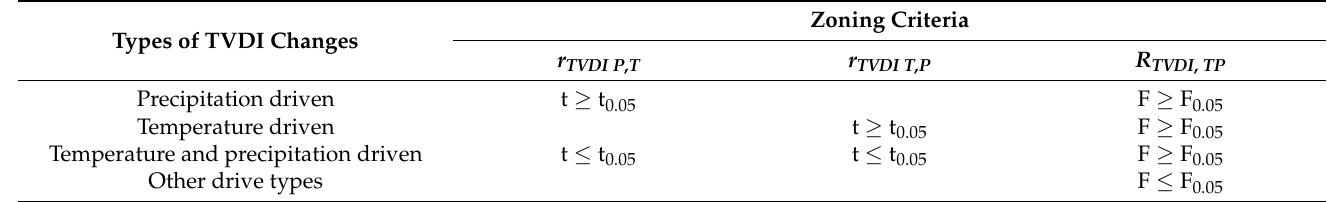
Table 2. Criteria for TVDI-driven zoning (It was reprinted with the permission from Ref. [56] Copyright 2022,